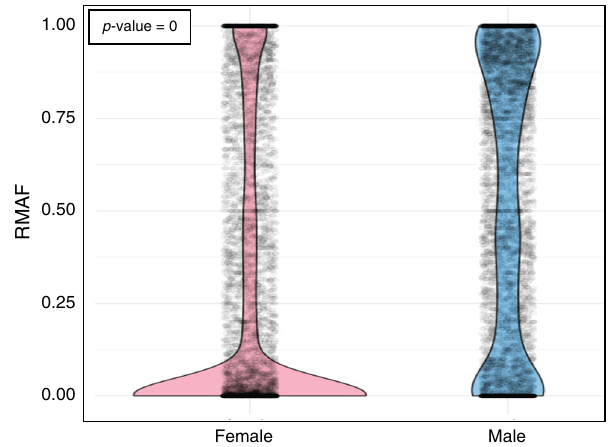
Fig. 3 RNA-mutated allele frequency (RMAF) for X-chromosome genes was particularly high in male cancers, while in female cancers most mutations were not expressed. RMAF was calculated for the 12 disparity cancers, for females and males independently (and pertinently this combined data re fl ects the individual cancers as evident in Supplementary Fig. 2c). RMAF was quanti fi ed using a scale between 0 and 1. For a speci fi c exome nucleotide mutation, 0 indicates the complete absence of mRNA for this particular mutation, where the gene is expressed at the mRNA level; 1 de fi nes mutation in this nucleotide in the corresponding mRNA in 100% of cases. Females are indicated in pink and males in